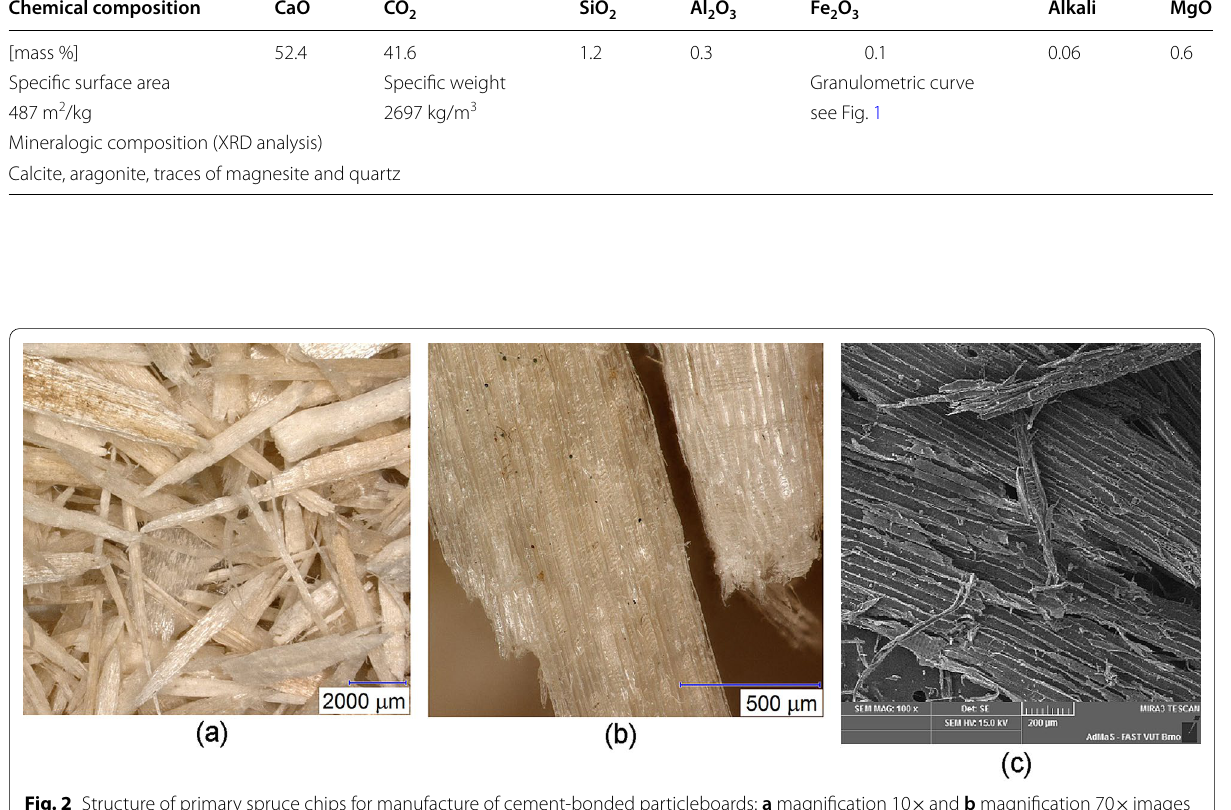
and b magnification 70 images × ×